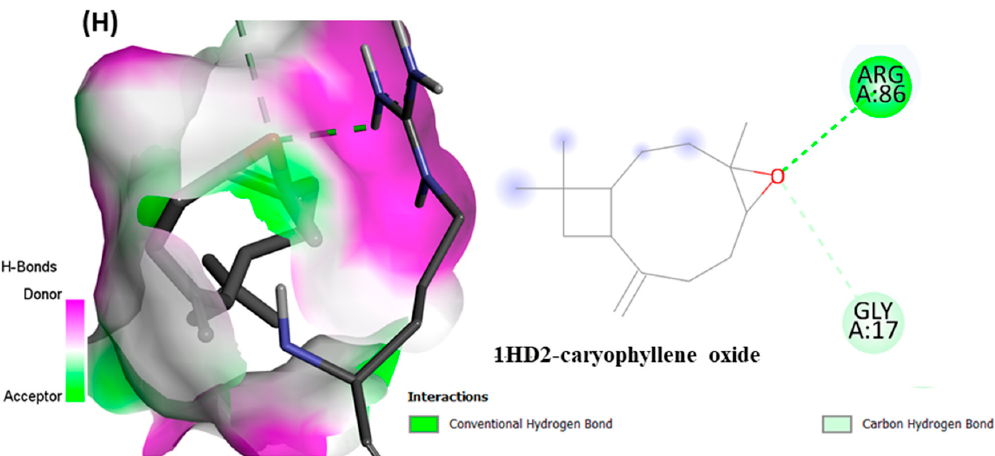
Figure 6. ( A – H ) Docked conformations of molecules in the binding cavity of HPPD (PDB: 6J63) and human periredoxin 5 (PDB: 1HD2) with least binding energies. The complex established are ( A ) 6J63-NTBC, ( B ) 6J63-13- epi -manoyl oxide, ( C ) 6J63-5-(1-Isopropenyl-4,5-dimethylbicyclo